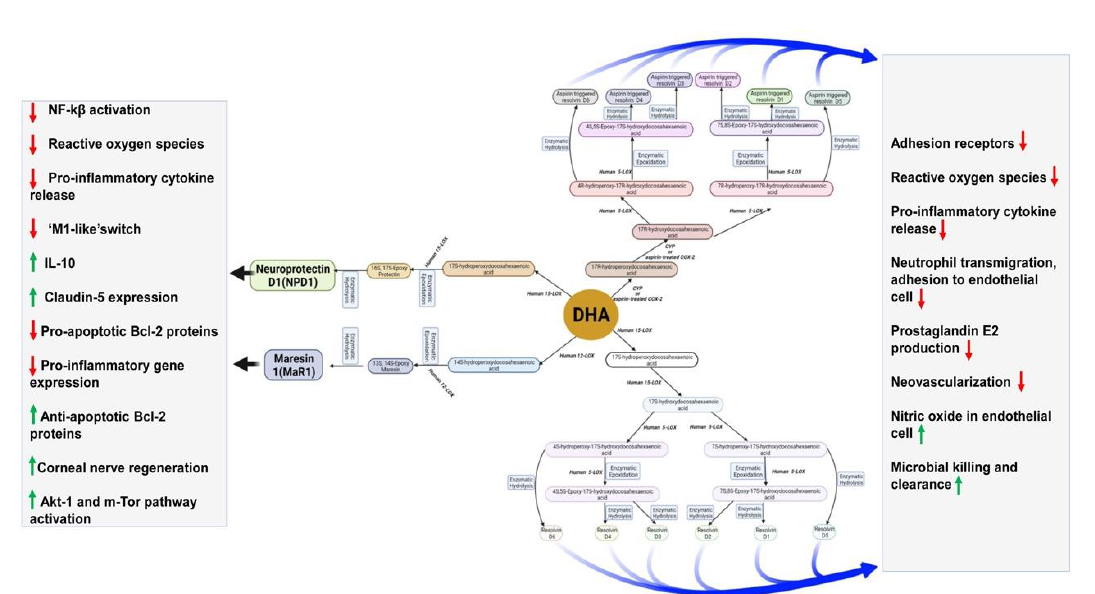
Table 1. Functions of DHA and ARA metabolites.